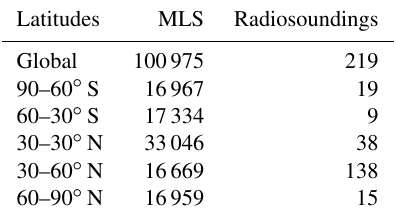
Table 1. Number of validation profiles for July